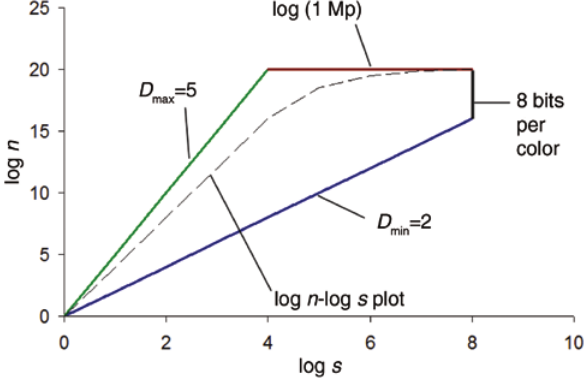
Figure 2: Quadrilateral of limits of log n -log s plot for an 1 Mp RGB image with 8